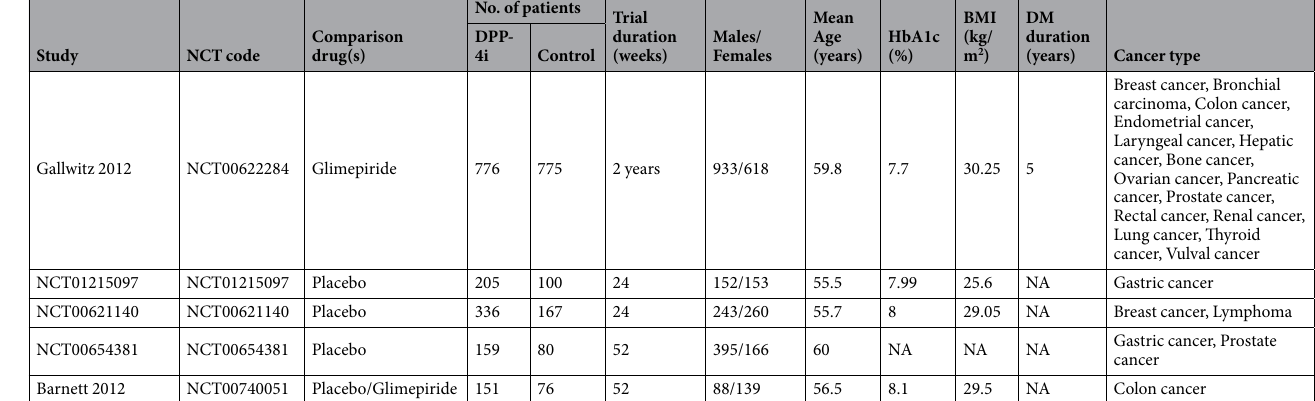
Table 1. Characteristics of included randomized controlled trials. NA, not available; NCT: national clinical trial; DPP4i: dipeptidyl peptidase-4 inhibitors; OAD: oral antidiabetes drug (excluding other DPP-4 inhibitors, GLP-1 analogs, and